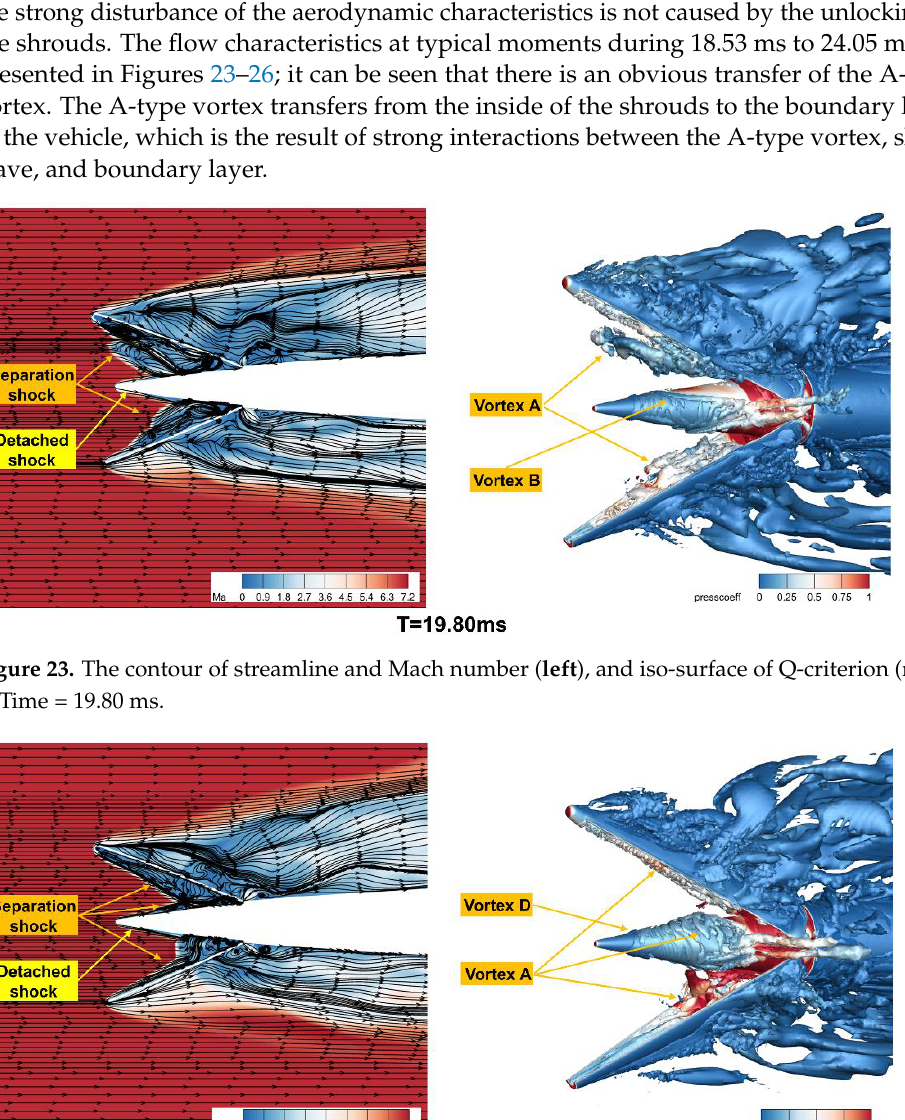
Figure 25. The contour of streamline and Mach number ( left ), and iso-surface of Q-criterion ( right ) at Time = 21.60 ms.